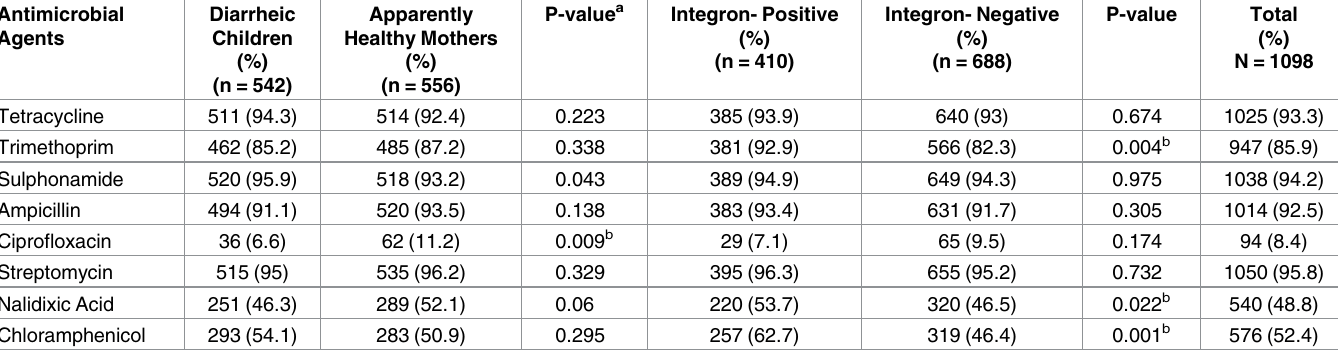
Table 1. Antimicrobial resistance patterns and integron contents of faecal Escherichia coli isolates from mother and child pairs. Antimicrobial Agents